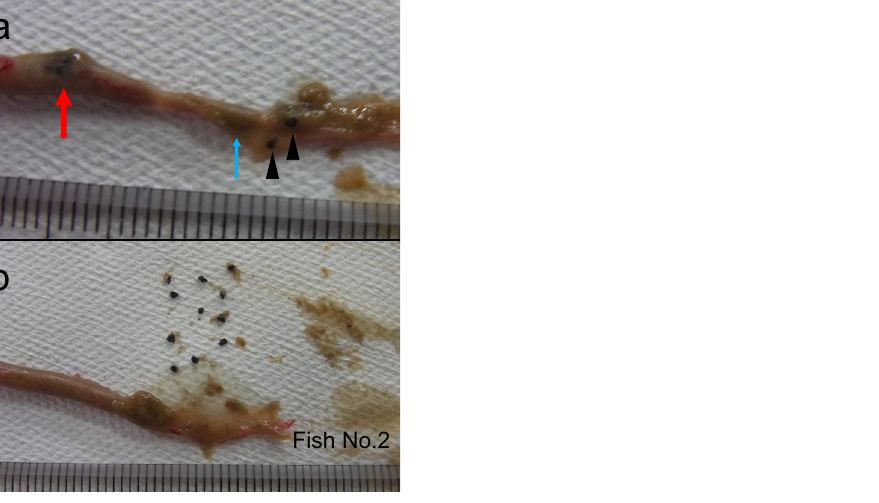
Figure 6. Rubber tips found in the intestine of goldfish (Fish No. 2). Sixteen pieces of rubber tips were found in the intestine in total. ( a ) A red arrow indicates a mass of eleven pieces of rubber tips. A blue arrow indicates a mass of three pieces of rubber tips. Arrowheads indicate one piece of rubber tip. ( b ) Eleven pieces of rubber tips came out from the intestine at the site indicated with a red arrow in photograph ( a